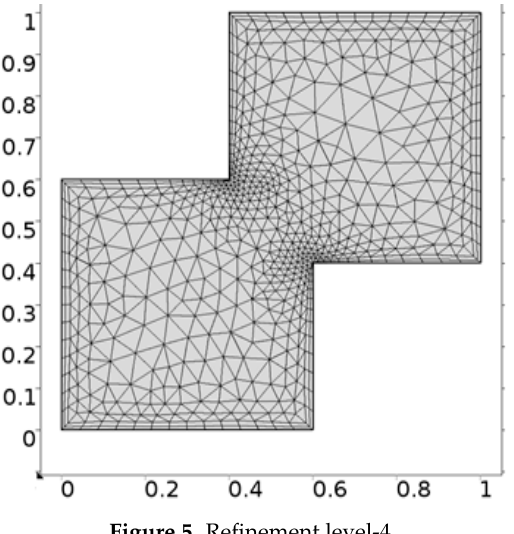
Figure 5. Refinement level-4.